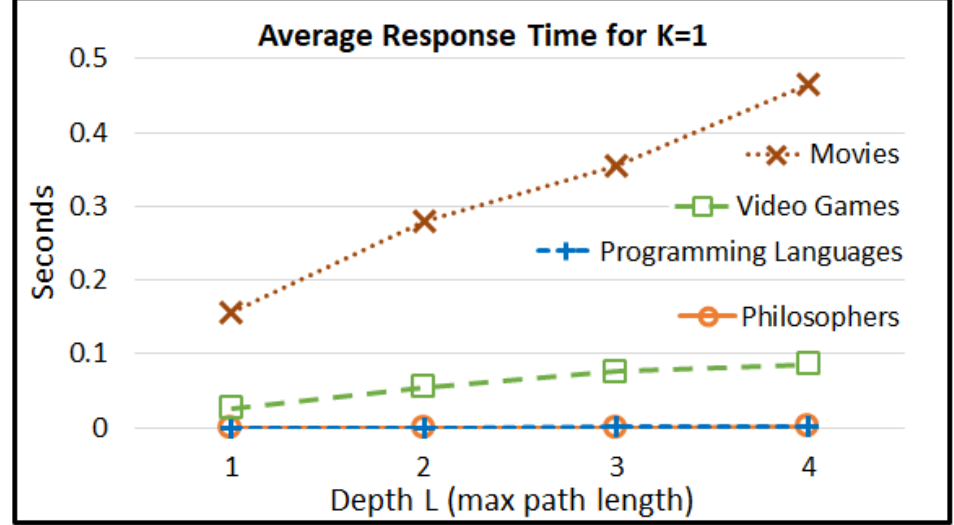
Figure 9. Average time for creating the similarity graph for K =